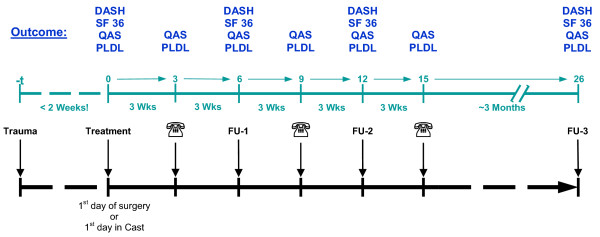
Follow up procedures. At 6-weeks, 3-months and 6-months, the determination of the outcomes is done during in-house visits of the patients in the clinic. At 3-weeks, 9-weeks and 15-weeks, the QAS and PLDL-wrist questionnaires are retrieved via telephone interview.